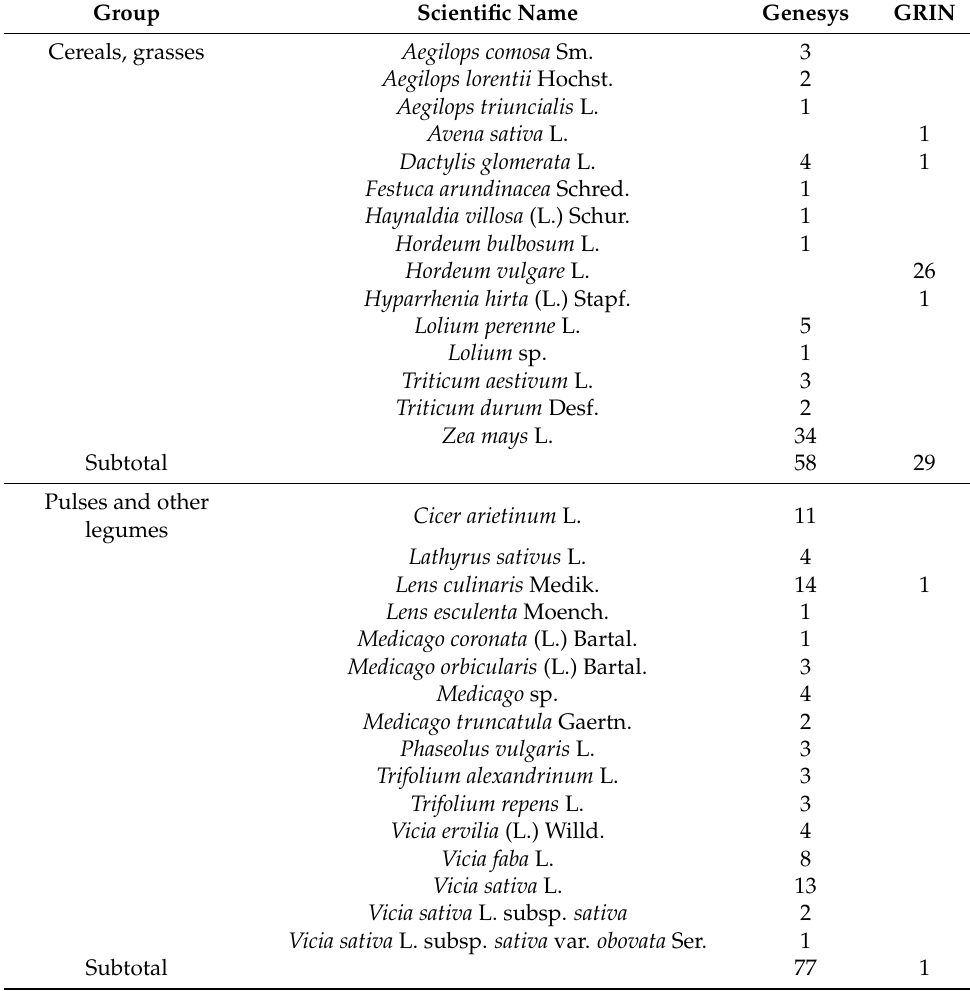
Table 2. Collection of plant species of Arcadia extracted by